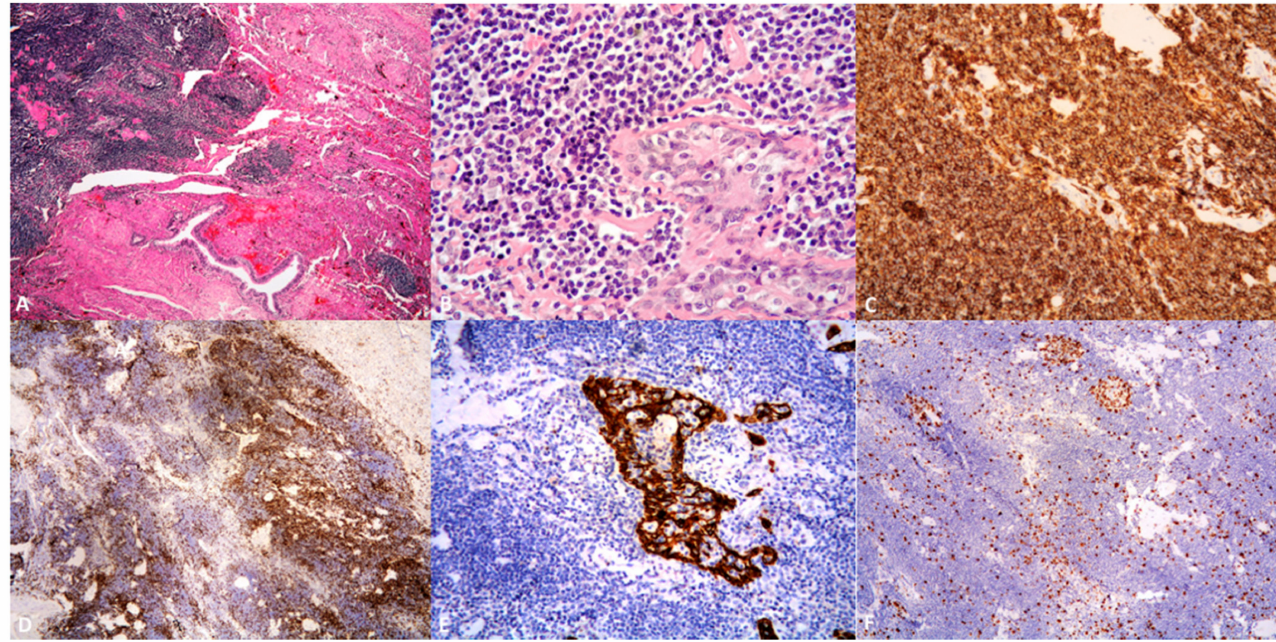
Figure 2. Primary pulmonary MALT lymphoma. ( A , B ). A dense infiltrate of mostly centrocyte-like lymphocytes effaces the lung parenchyma (A H&E stain, 40 × ; B H&E stain, 400 × ). ( C , D ). Neoplastic cells are CD20+ with a minor population of reactive CD3+ T-cells; both antibodies feature a membranous staining (( C ) CD20 immunostain, 200 × ; ( D ) CD3 immunostain, 100 × ). ( E ). Lymphoepitelial lesions due to neoplastic cells infiltrating the epithelium are highlighted by cytokeratins (CK-AE1/AE3 immunostain, 200 × ). ( F ). The proliferative index, i.e., the percentage of Ki-67 stained nuclei, is low in the neoplastic cells, but higher in residual germinal centers (Ki-67 immunostain, 100 ×